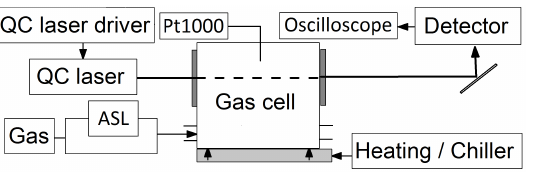
Figure 2. Scheme of the experimental setup. A detailed description can be found in the